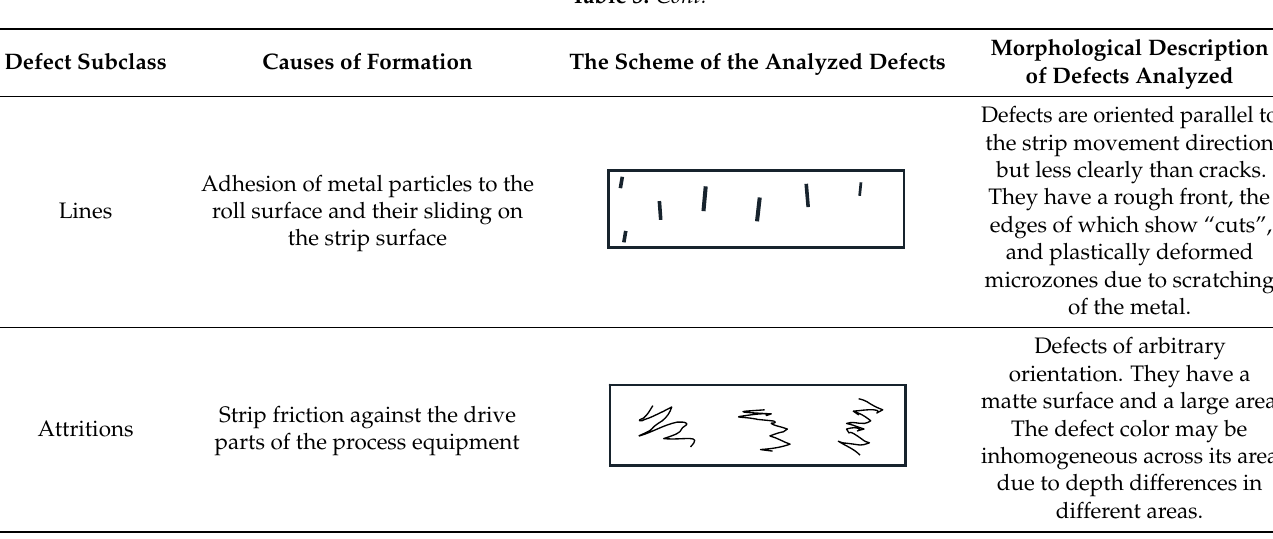
Table 3. Morphological features, causes of formation, and morphological description of defects of class “scratch, line, attrition”. Table 3. Cont.